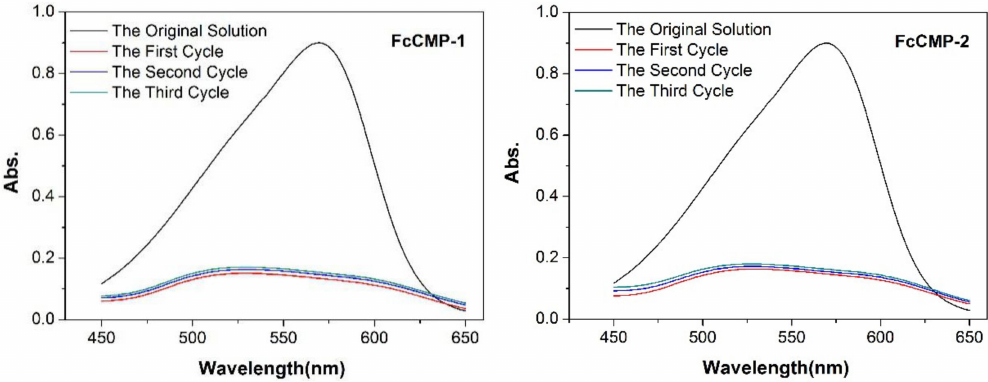
Figure 7. UV spectra of original and collected MV solution after adsorbed by FcCMP-1 and FcCMP-2.